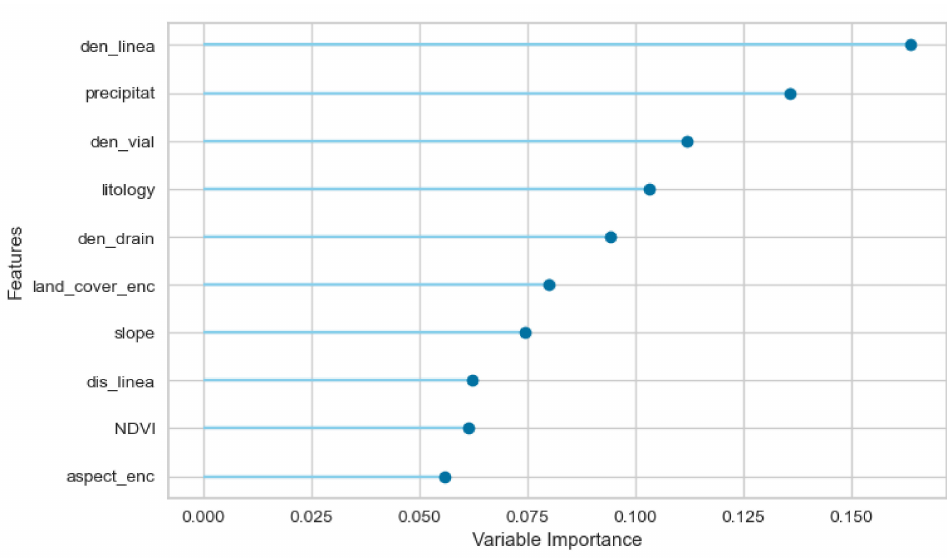
Figure 7. Importance of the explanatory variables, according to the extra trees trained